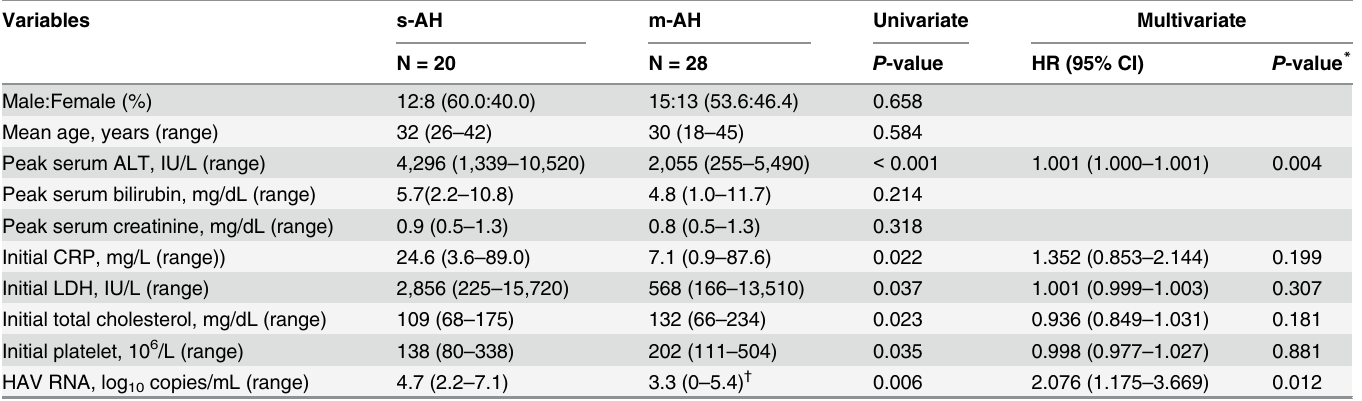
Table 3. Univariate and multivariate analyses for predictive factors associated with severe acute hepatitis A among 48 patients who were tested for HAV RNA titer.